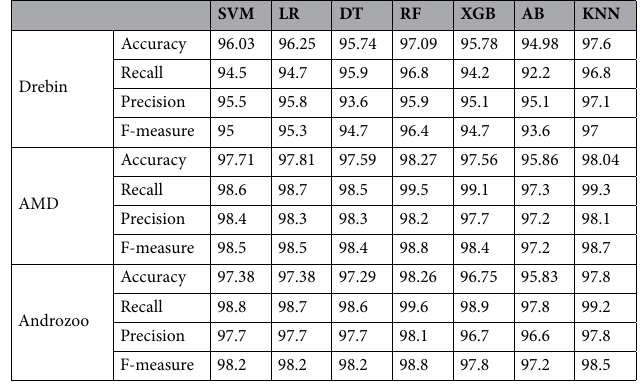
Table 10. Results of classifiers on Datasets using Random 80/20 Train and Test Splits.